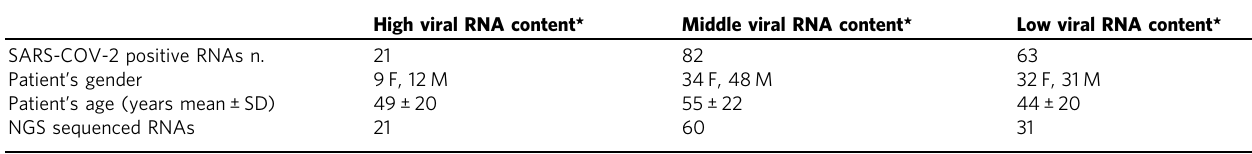
Table 1 Summary information about SARS-COV-2 positive RNA samples and individuals included in this study. High viral RNA content* Middle viral RNA content* SARS-COV-2 positive RNAs